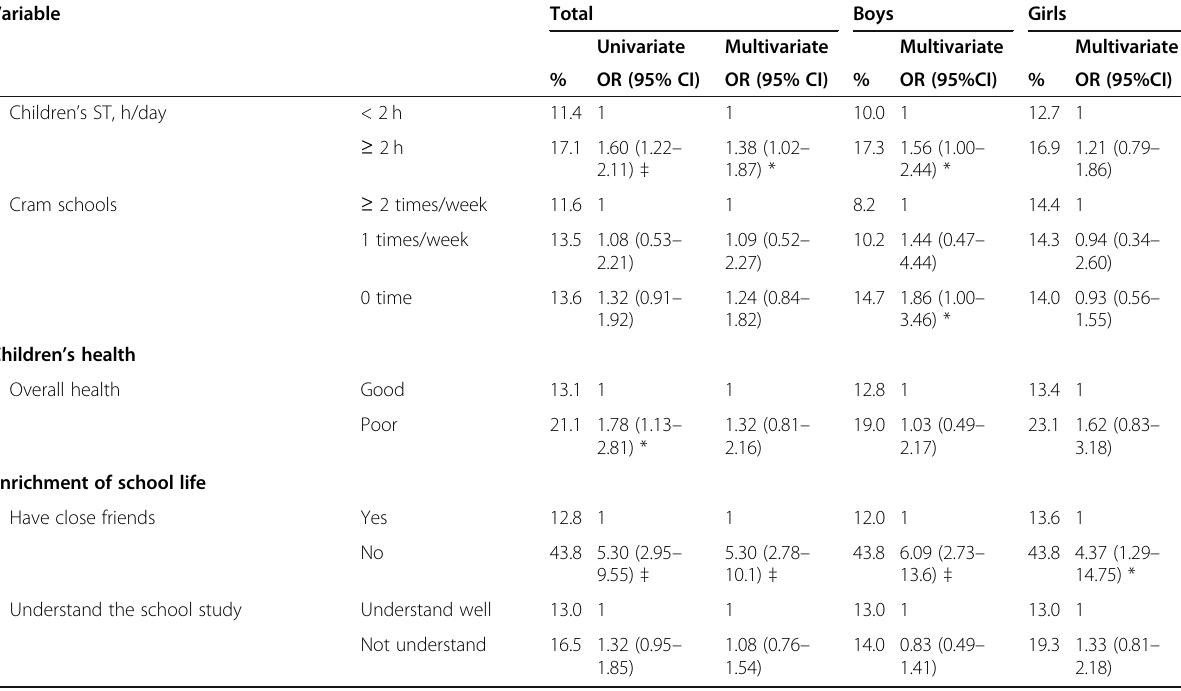
Table 2 Logistic regression analysis results for “ Don ’ t like physical activity ” ( n = 1721) (Continued)